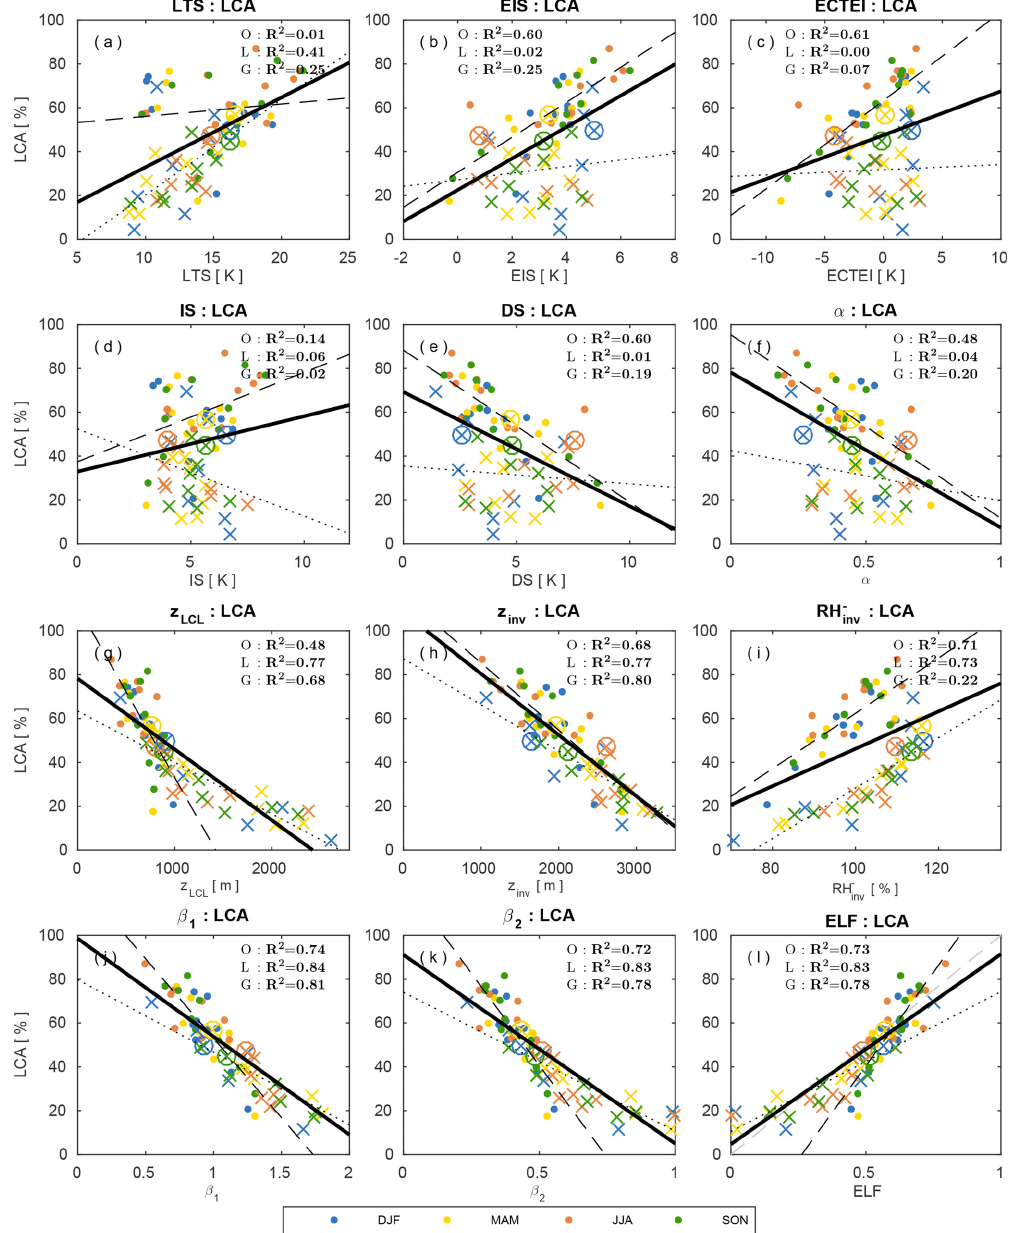
Figure 8. Scatter plots between the seasonal LCA and various proxies over selected regions of Fig. 7. Different colors denote different seasons. The ocean and land regions are denoted by dots and “x” marks, respectively, except for the China stratocumulus deck, which is denoted by the circled “x” marks. Also plotted are the least-squares fitting lines for ocean (O; dashed line), land (L; dotted line), and globe (G; thick solid line), respectively, with the fraction of variance ( R 2 ) explained by the regression lines. Only the data satisfying 0 < α < 1 are used for this